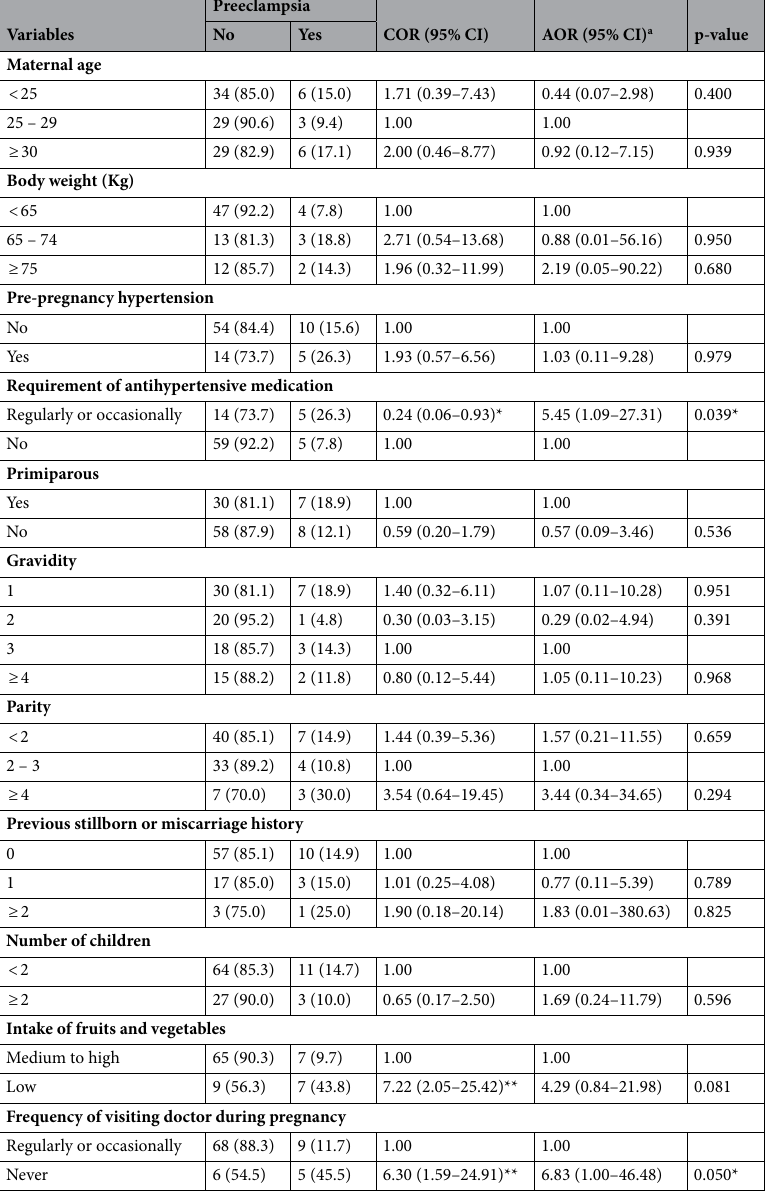
Table 5. Multiple logistic regression analysis of factors that can be associated with preeclampsia among pregnant women. *p < 0.05; **p < 0.01. a Adjusted for the variables found significant in univariate regression analysis (Requirement of antihypertensive medication, intake of fruits and vegetables, frequency of visiting doctor during